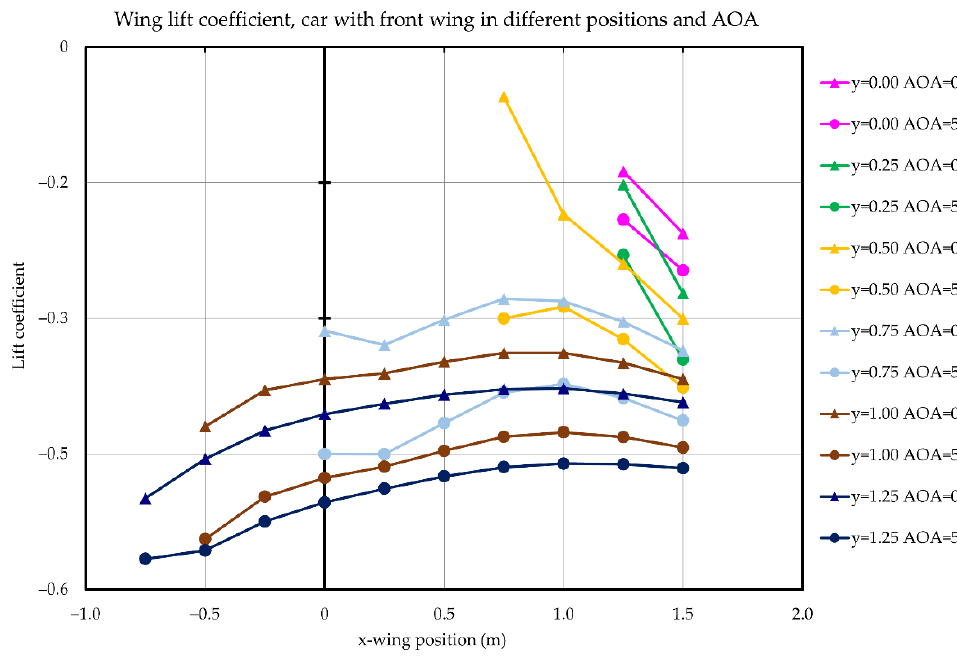
Figure 28. Changes in the coefficient of the aerodynamic lift force generated only by the front wing at different positions relative to the body.